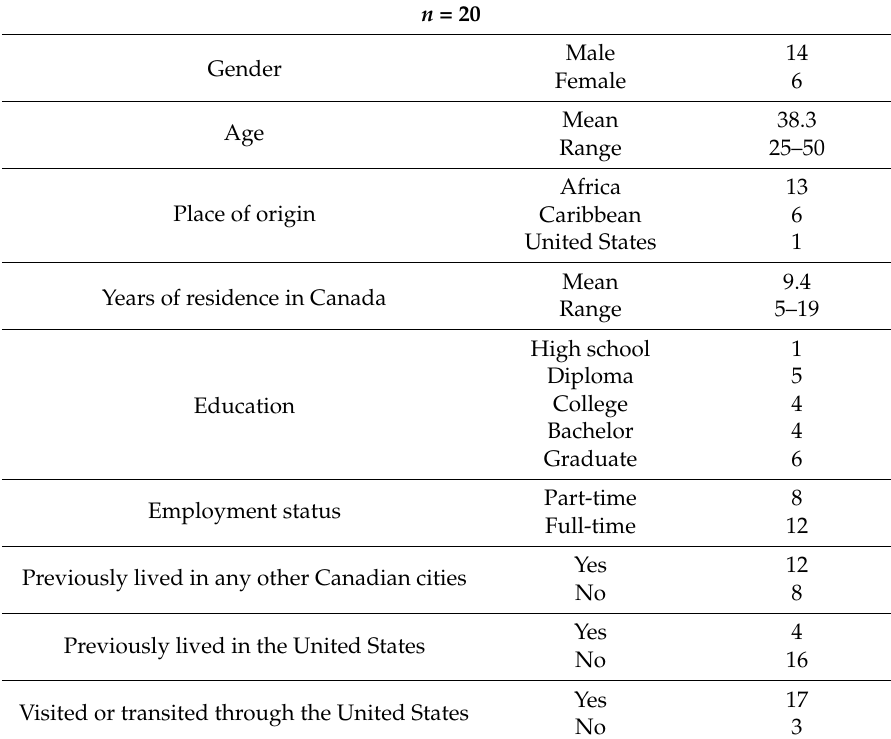
Table 2. Sociodemographic characteristics of